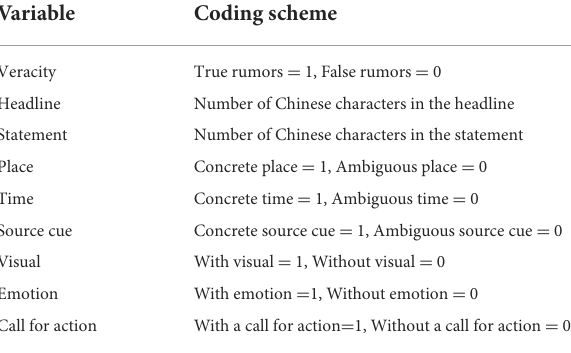
TABLE 2 Coding schemes for the content characteristics of COVID-19 rumors. Variable Coding